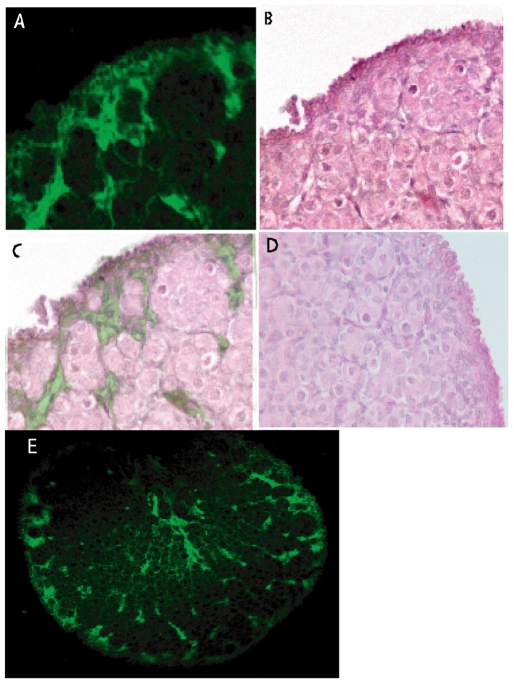
Ovarian morphology and immunohistochemical localization of AMH.(A) Fluorescent immunohistochemical localization of AMH protein (green) in cortex of 3-day old rat ovary. (B) Hematoxylin/eosin (H and E) stain of the same ovarian section as was used for immunohistochemistry. (C) Overlay of immunohistochemical localization of AMH (green) onto H and E stained section (i.e. A onto B). AMH is present in the stromal cells around groups of forming and newly formed primordial follicles. (D) An additional H and E stained ovarian cross-section from the same ovary, with more clear morphological detail than was possible with the re-stained section in B. (E) Immunohistochemical localization of AMH across the entire ovarian cross-section, showing AMH to be present near the ovarian cortex and in stromal bands in tzhe medulla.